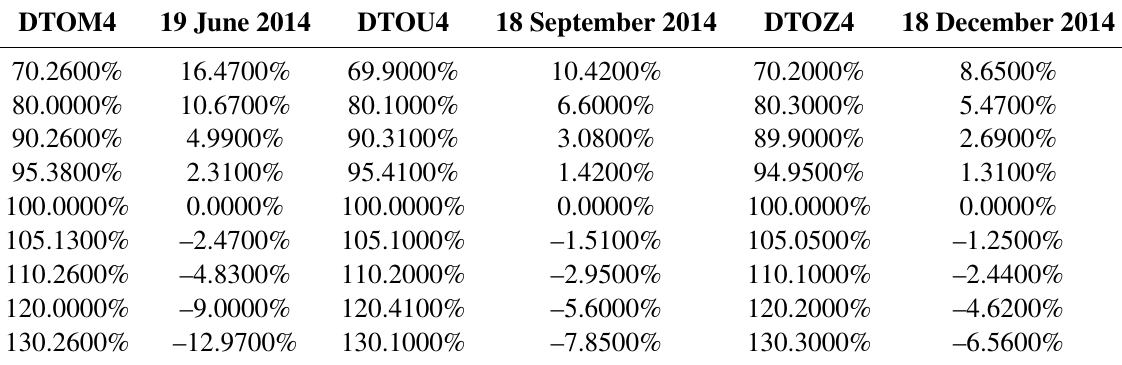
Table 4. Floating DTOP skews for 3 expiry times on 28 May